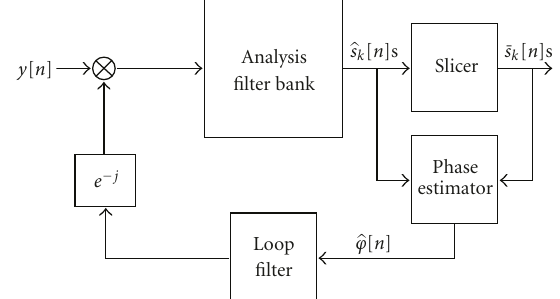
Figure 7: A PLL equipped FBMC receiver. The input y [ n ] is the demodulated received